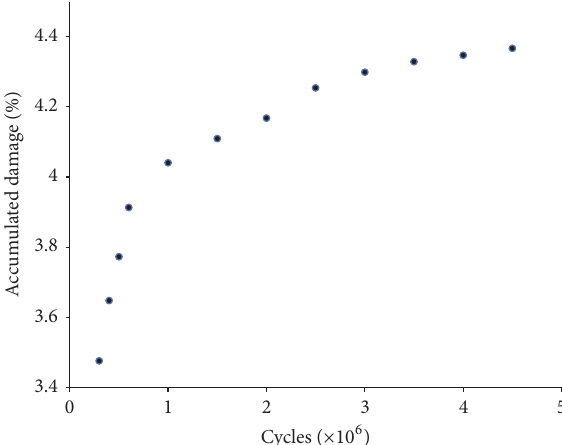
Figure 7: Accumulated damage within the cement as a function of the number of loading cycles (design life of 10 9 cycles). The growth rate of fatigue damage is rapid and significant at early loading cycles gradually decreasing in subsequent stages of the